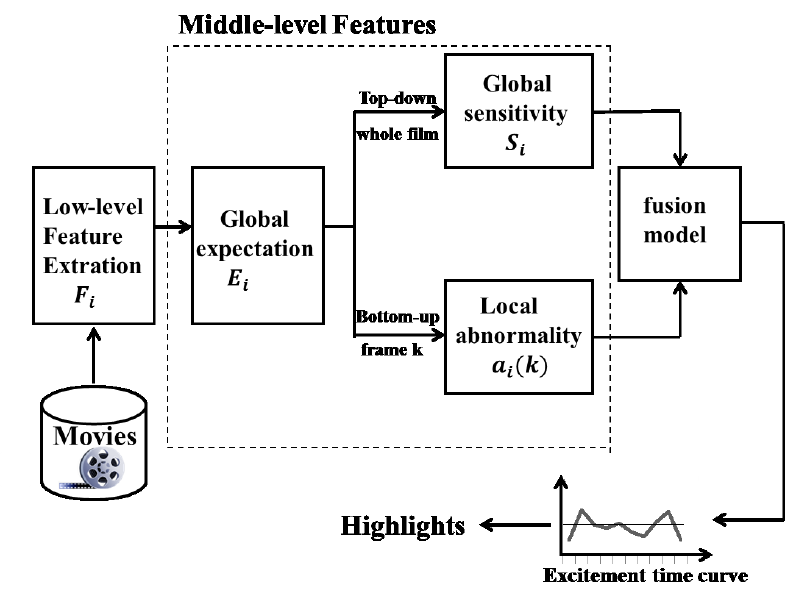
Figure 1. Proposed cognitive psychology framework-based